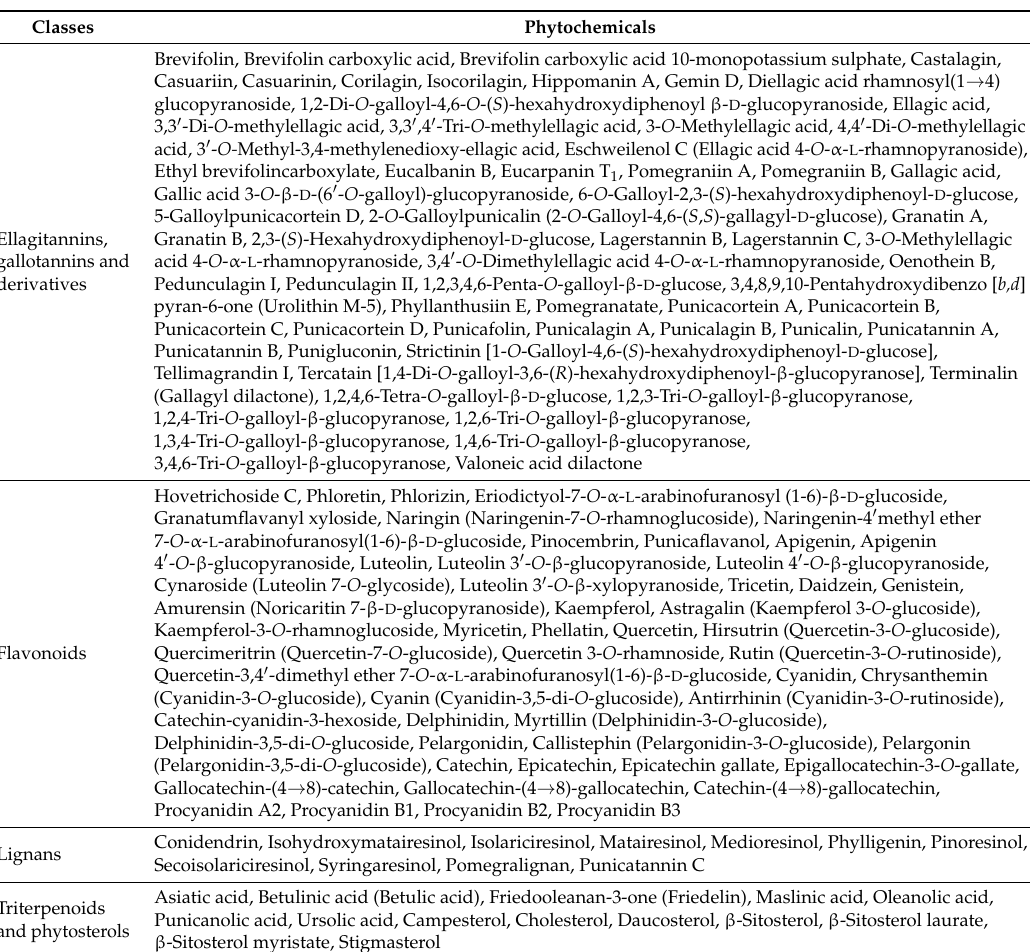
Table 1. Different classes of phytochemicals identified from pomegranate. Detailed descriptions of the chemical structures, molecular formulas, molecular weights, tissues of identification, and representative references are presented in Supplementary Table